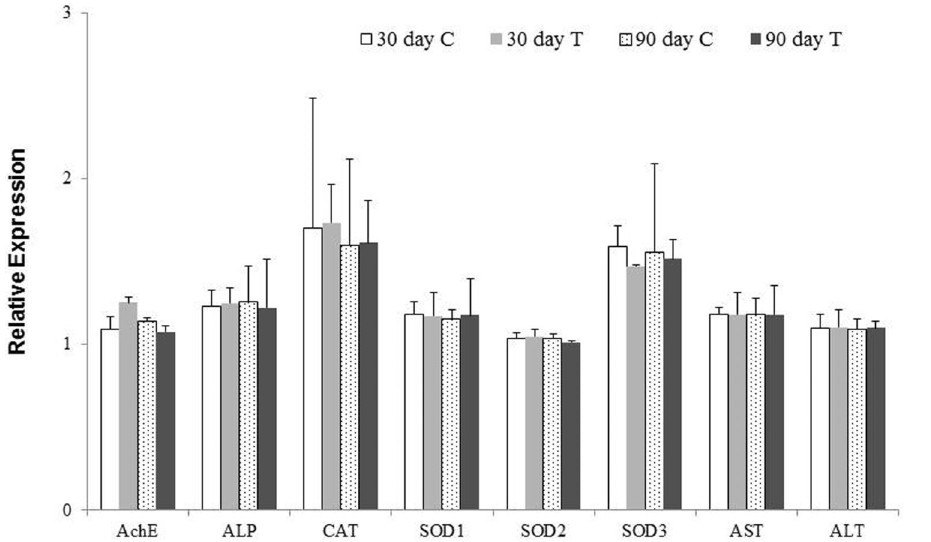
Figure 8. qPCR analysis of several genes in Swiss rat fed with Cry1Ab protein for 30 and 90 days. C, control; T, fed with Cry1Ab (test). Columns represent means of three individual measurements and bars indicate standard errors of the mean (SEM). The genes encode AchE, CAT, SOD1, SOD2, SOD3, ALP, AST and ALT respectively.